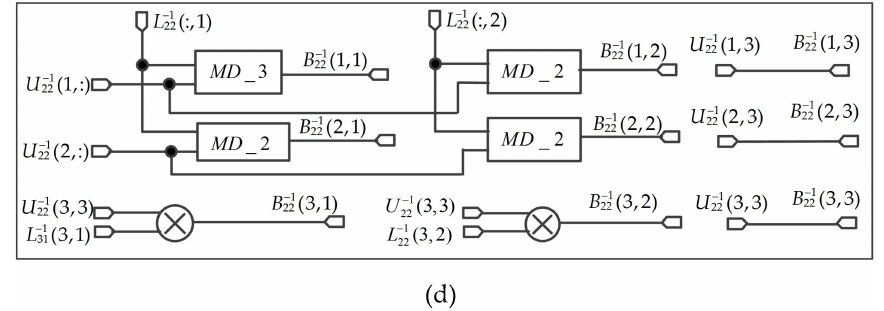
− 1 . ( a ) Calculate U − 1